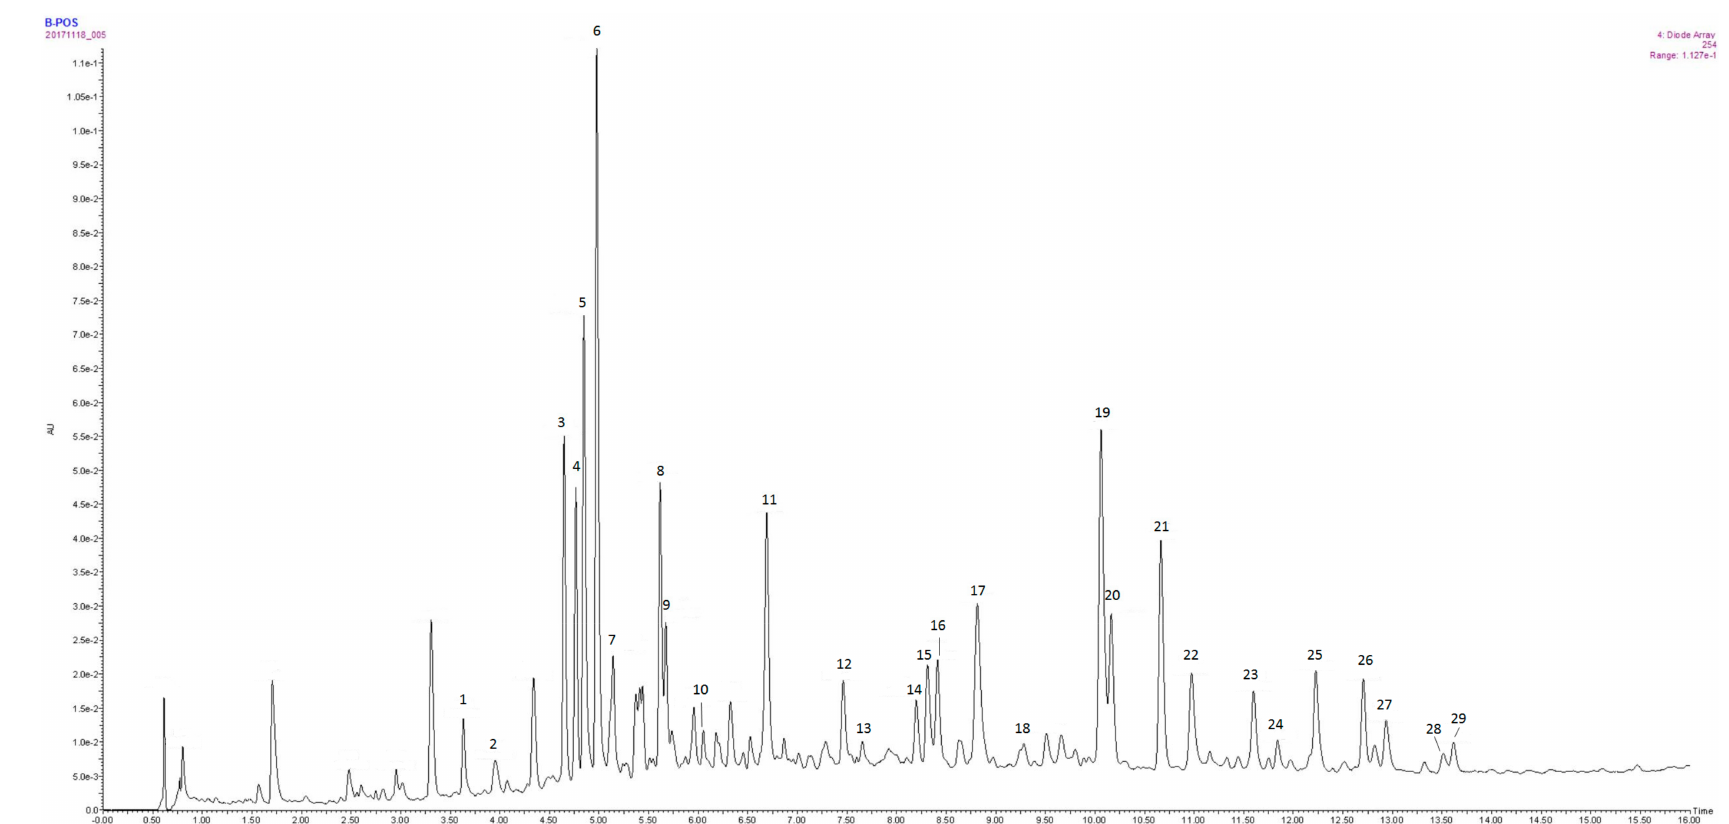
Figure 1. UPLC chromatograms at 254 nm of total flavonoids sample in positive ion modes analyzed by